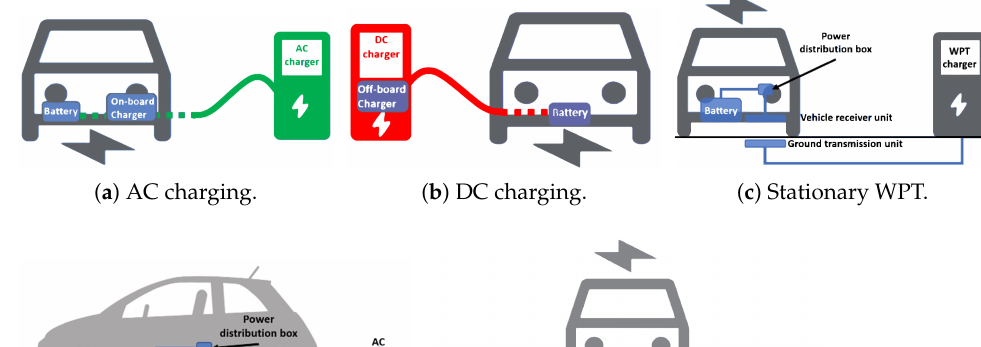
Figure 8. Charging stations classification.